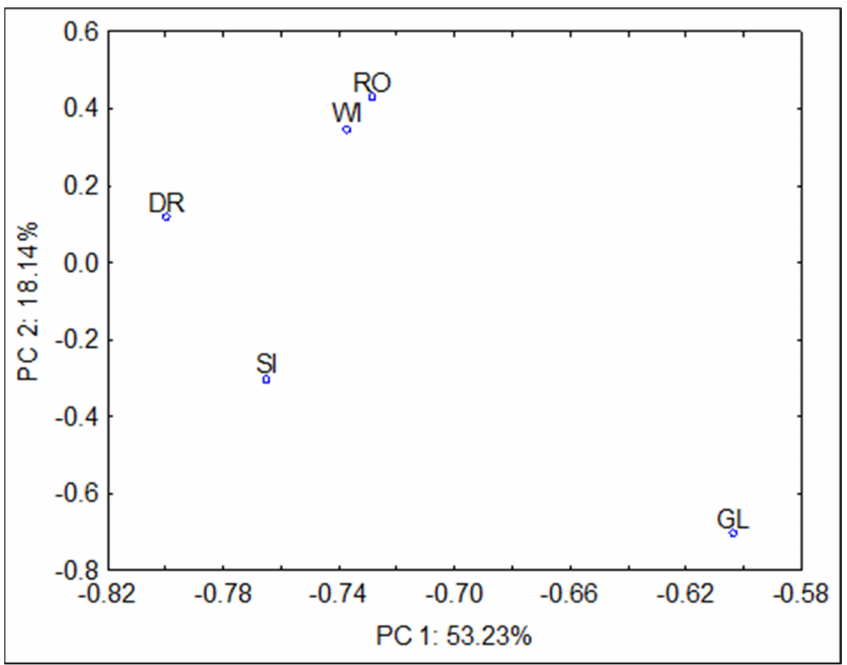
Figure 4. Loading scatter plot for PC1 (principal component 1) versus PC2 (principal component 2), along with percentage of total variance explained by PC1 and